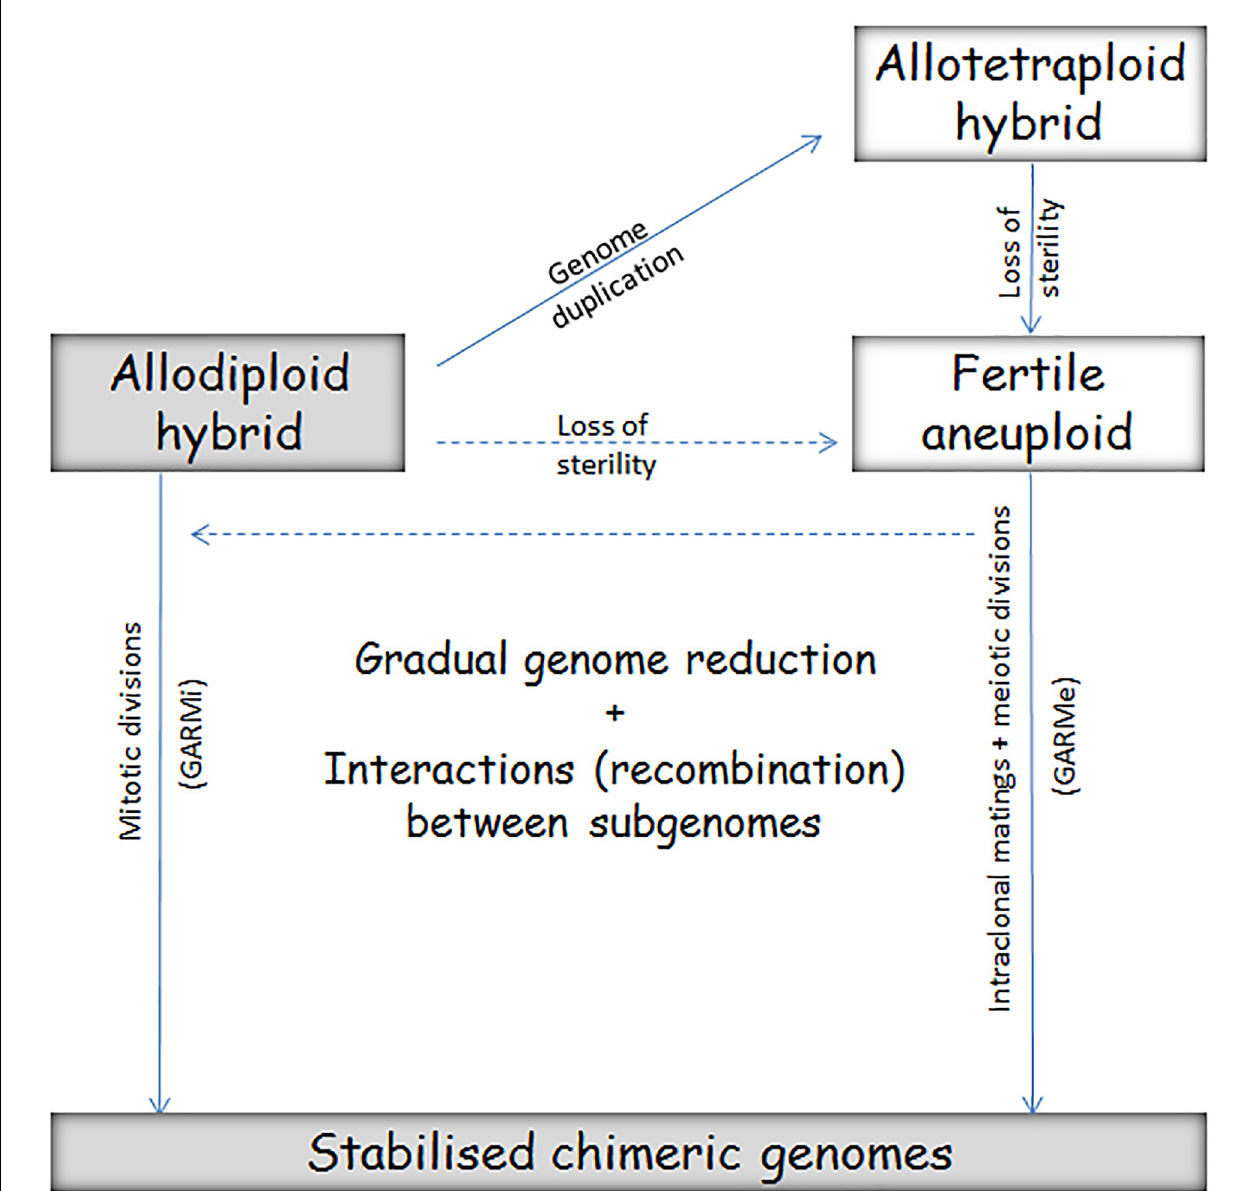
FIGURE 4 | Two pathways of conversion of the interspecies hybrid into chimeric strains through genetically unstable intermediates. The conversion by serial biased mitotic segregation and recombination of chromosomes during vegetative propagation (GARMi) is exploited in the breeding strategy called adaptive evolution. As the outcomes are chimeric strains (“evolved hybrids”) that are genetically stable under the selective conditions that preferentially promoted their growth, the process is also called genetic stabilization of the hybrid. The alternative pathway leads to similar chimeric strains through biased segregation and recombination in a series of successive meiotic divisions (GARMe). The key events in this process are genome duplication, breakdown of sterility and autofertilisation (self-conjugation/mating) in the spore clones. Switching from one pathway to the other is possible (broken arrows). The fertile spores produced during GARMe can mate also with other fertile spores and cells of parental strains (a possibility for introgression). The allodiploid hybrids and the final chimeric strains are more suitable for biotechnological applications than the forms being in intermediary stages because the latter are less stable and may change unpredictably during propagation in the